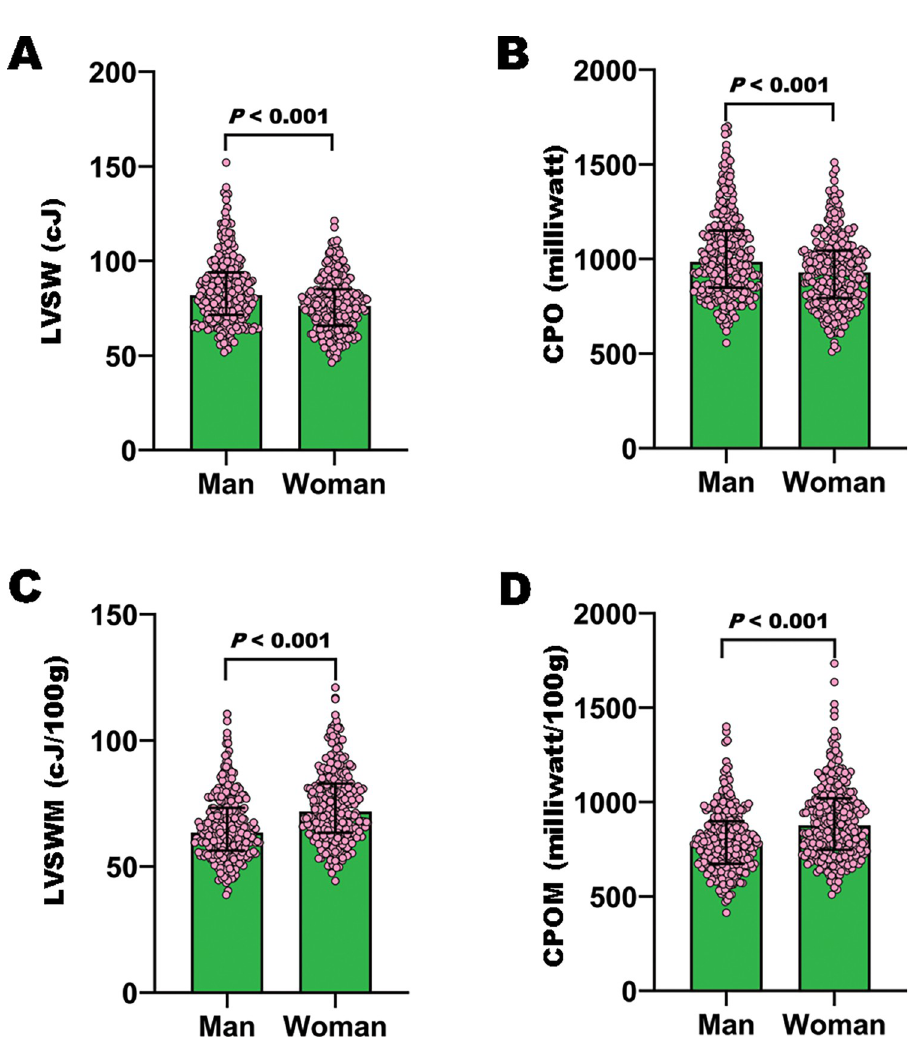
Fig 1. Sex difference in LV external work in 596 apparently healthy adults (298 men). The LVSW and CPO, which represent the overall LV function, are higher in men than in women (Fig A and B). The LVSWM and CPOM, which represent the workload per unit LVM, are higher in women than in men (Fig C and D). Nonstandard abbreviations and acronyms as in Table